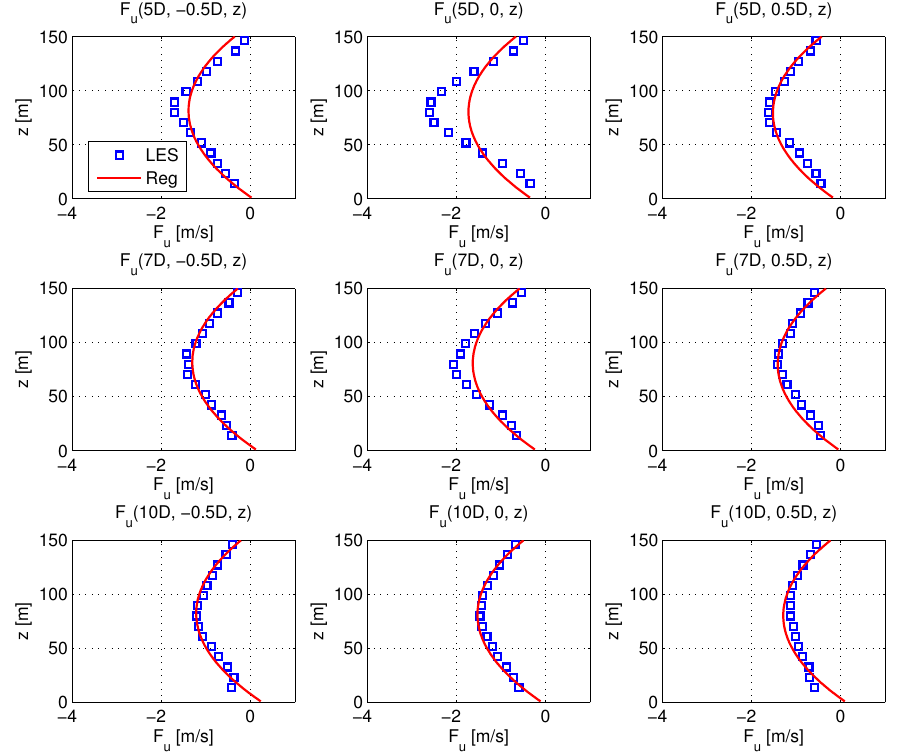
Figure 18. Spatial variation of F u : LES versus regression-based